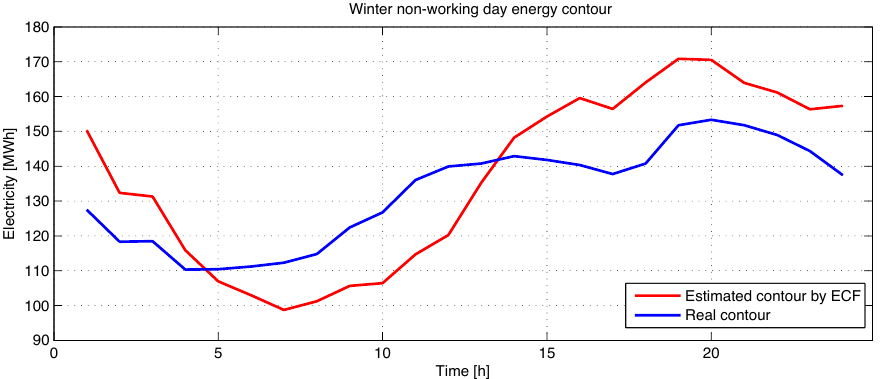
Figure 7. Estimation of energy contour by Frequency Feature Based Method (ECF) for a winter non-working